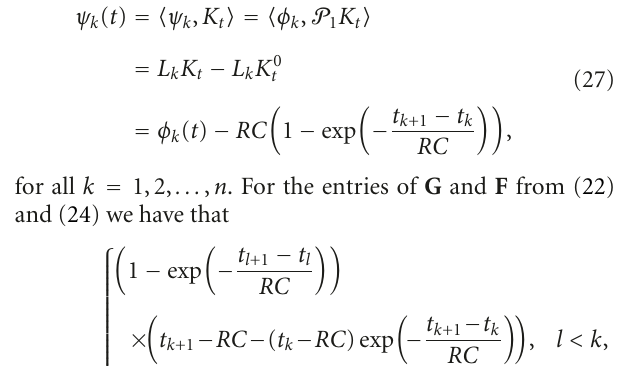
Algorithm 1. The coe ffi cients c and d satisfying the system of (20) are given by